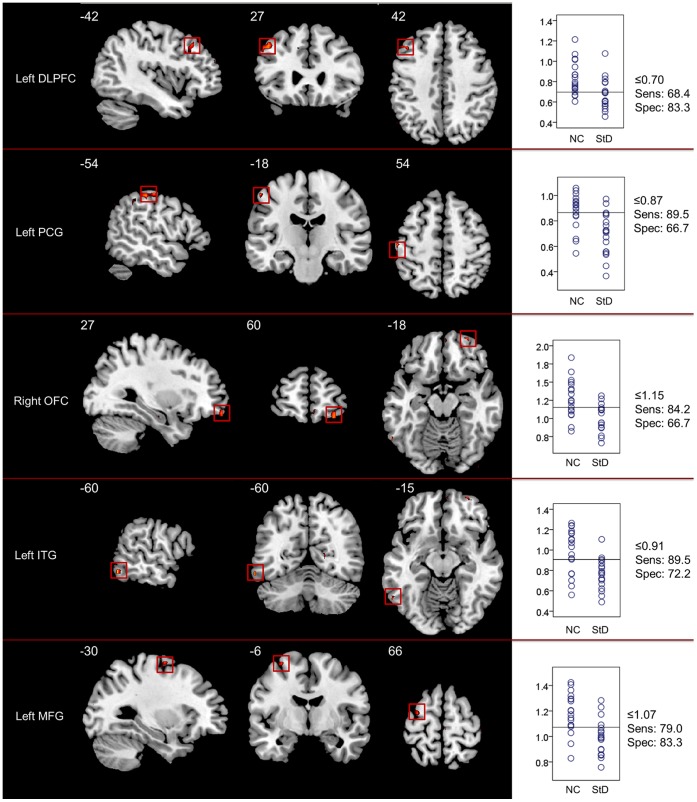
Brain regions (ROIs) showing significantly increased ReHo in NC (decreased ReHo in individuals with StD) (two sample t-test, thresholded at p<0.005 with an extent threshold 5 contiguous voxels, uncorrected) and their sensitivity/specificity plots.The left panel demonstrates the coronal, sagittal, and axial views of each ROI with the MNI location shown at the lower right. The right panel presents correspondingly the scatter plot for the ReHo in the region. Y-axis of the scatter plot is the extracted mean ReHo values, and the horizontal lines in the scatter plots are the cutpoints with the best separation between NC and StD that are evaluated from the ROC analysis. The sensitivity (Sens) and the specificity (Spec) at the cutpoints are shown at the right side of the scatter plots.